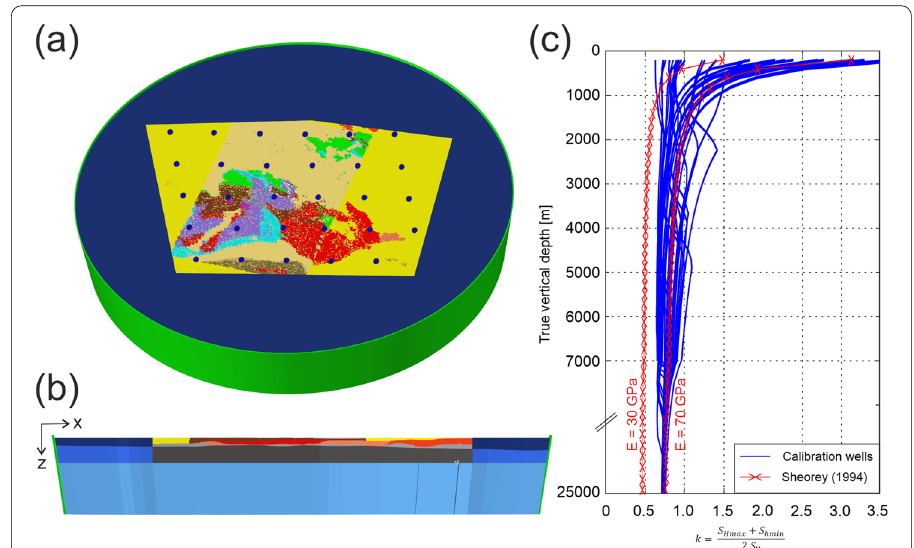
Fig. 3 Top ( a ) and side view ( b ) of the extended model box used to achieve an initial stress state. c Best‑fit of 29 virtual wells (blue curves) and blue dots in a in comparison to calculated curves (red) for a Young’s modulus of 30 and 70 GPa based on Sheorey (1994). There is a change of the scale of the depth axis